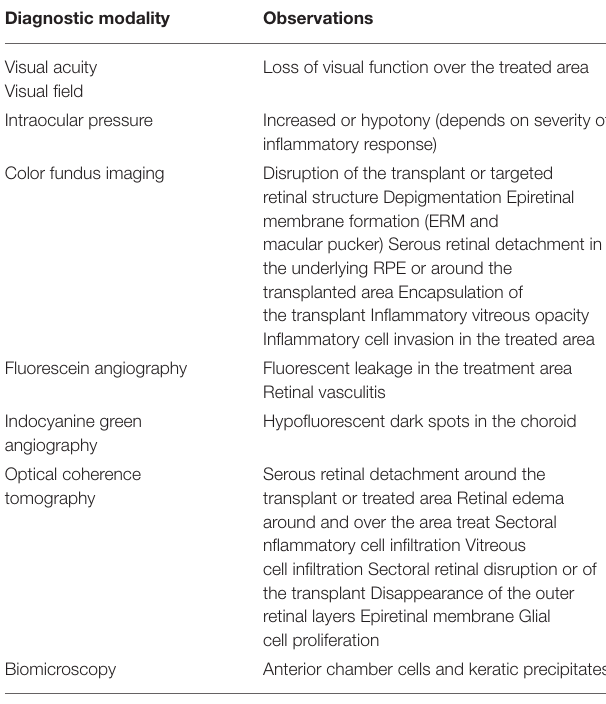
TABLE 2 | Ocular manifestations associated with immune activation by RPE allografts in animal models and in human clinical trials. Diagnostic